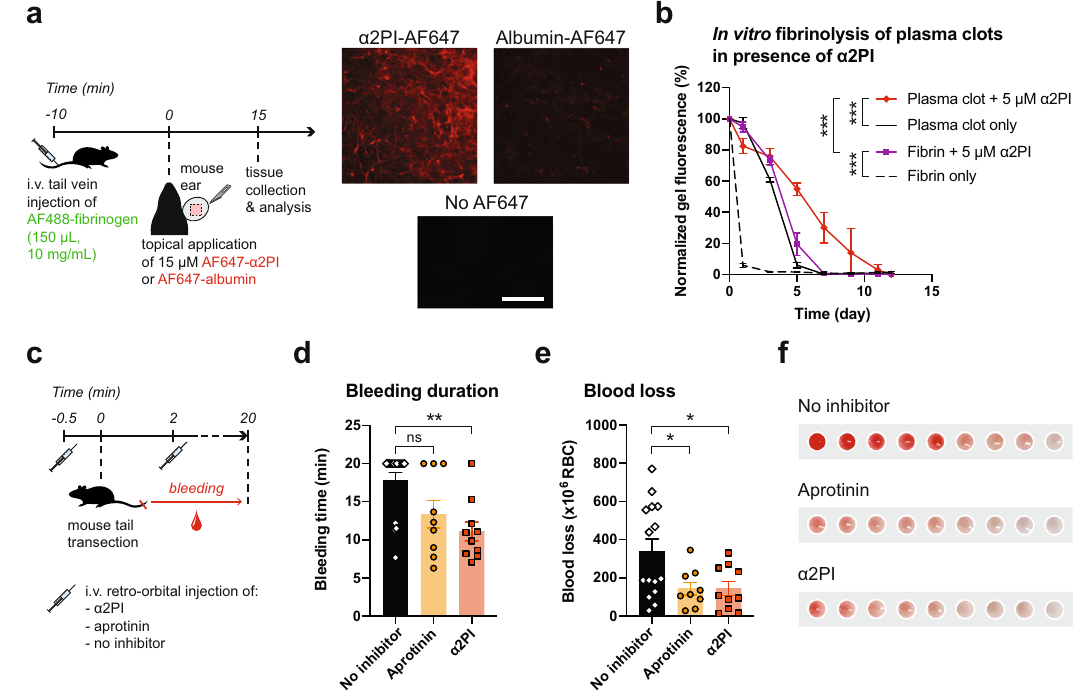
Fig. 4 α 2PI protects endogenous fi brin and reduces bleeding in a tail vein transection model in mice upon intravenous delivery. a Scheme of the experimental procedure and in situ crosslinking of α 2PI in endogenous fi brin on wounds, as compared to non-binding albumin. Fluorescently-labelled α 2PI or albumin was added directly upon wound induction on mice ear fl ap. The wounds were then extensively washed to remove unbound proteins, before microscopic imaging (representative images of n = 3, scale bar = 100 μ m). b In vitro fi brinolysis of clots polymerized from unpuri fi ed mouse plasma (i.e. plasma clot) supplemented or not with 5 μ M of α 2PI and in the presence of 2.5 nM of plasmin. The plasma was mixed with 10% fl uorescently-labelled exogenous fi brinogen prior to clotting to allow quanti fi cation of clot degradation via IVIS imaging. Mean ± SD. c In vivo tail bleeding model C57BL6/J in mice ( n ≥ 9 mice/group). α 2PI or aprotinin (180 μ M, 100 μ L) was injected retro-orbitally, 30 sec prior to full transection of the tail tip and 2 min after. The bleeding time was measured from the time of tail transection and up to 20 min later, during which the blood was collected for further quanti fi cation. d Bleeding time of mice injected with α 2PI, aprotinin or no inhibitor. Statistical comparisons were done using Kruskal – Wallis test with Dunn ’ s post-hoc test. e Blood loss is quanti fi ed via the amount of lost red blood cells (RBC) upon injection of the different inhibitors. f Representative images of blood samples collected from mice treated with α 2PI, aprotinin or no inhibitor (red intensity = increase in blood loss). Mean ± SEM if not stated otherwise. Statistical comparisons were done using ANOVA test with Dunnett ’ s post-hoc test if not stated otherwise: * p -value < 0.05, ** p -value < 0.01, *** p -value < 0.001, ns non-signi fi